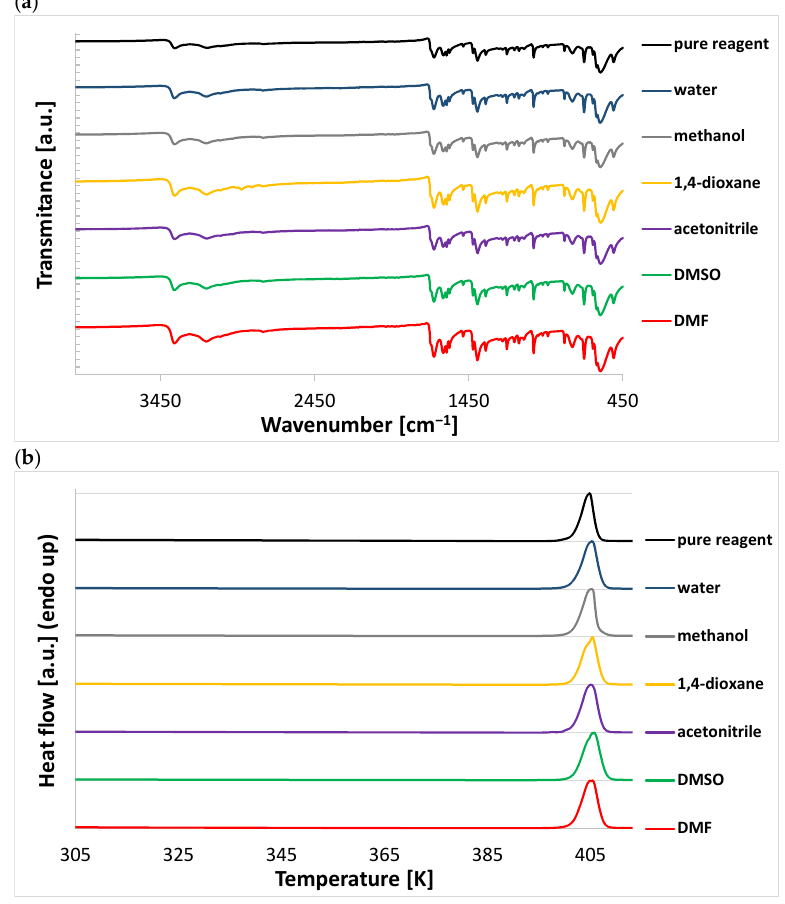
Figure 5. Results of the instrumental characteristics of pure nicotinamide and the sediments ob- tained after solubility measurements in pure solvents ( a ) FTIR-ATR spectra ( b ) DSC thermograms.